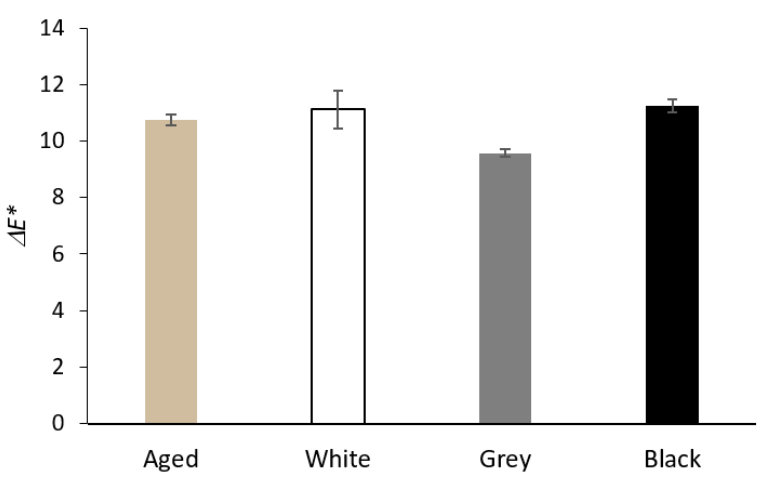
Figure 9. The total color difference of wood-pulp paper after artificial aging without contact with PE foam (Aged) and in contact with the tested PE foams.